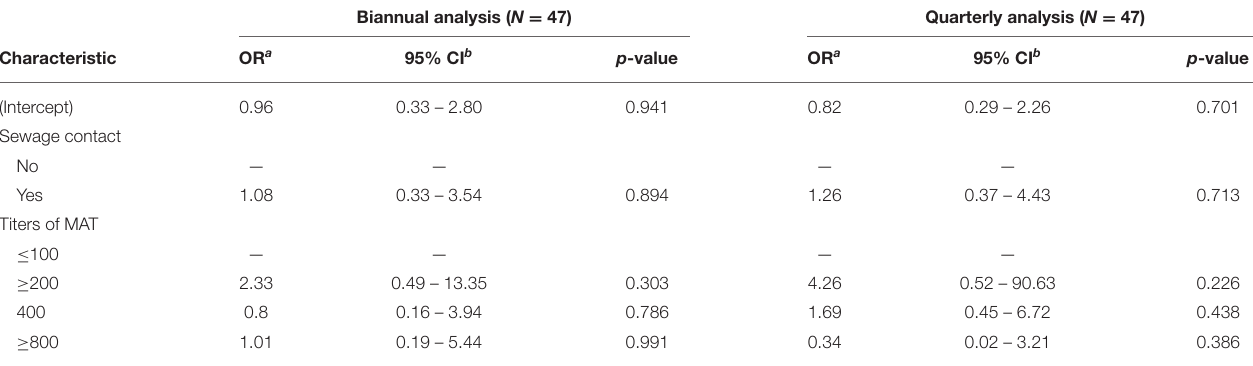
TABLE 3 | Multivariate analysis to evaluate MAT titers as immune markers for reinfection on biannual and quarterly